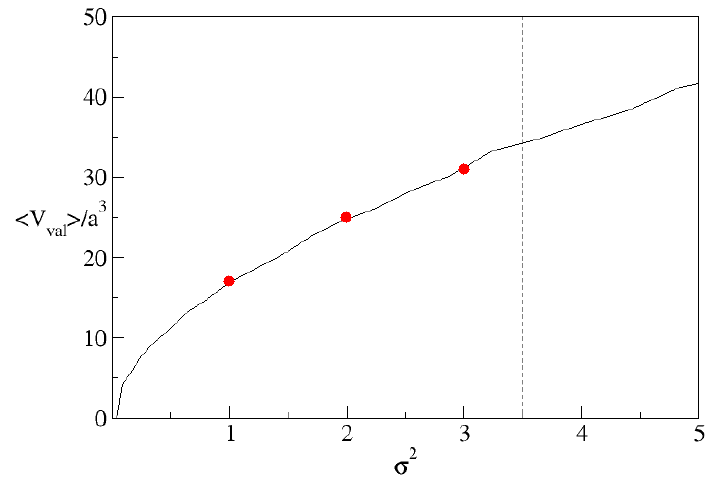
Figure 10. Average pore (valley) volume as a function of the variance of the surface height for correlation length ξ = 20. The values were obtained by averaging the valley volumes (defined as the volume from a valley minimum up to h = − 1) over all pores on a thousand realizations of the surface. The dots indicate the values of σ corresponding to the curves in Figure 9. The dashed line marks the value of σ beyond which clusters grow attached to the substrate as per Figure